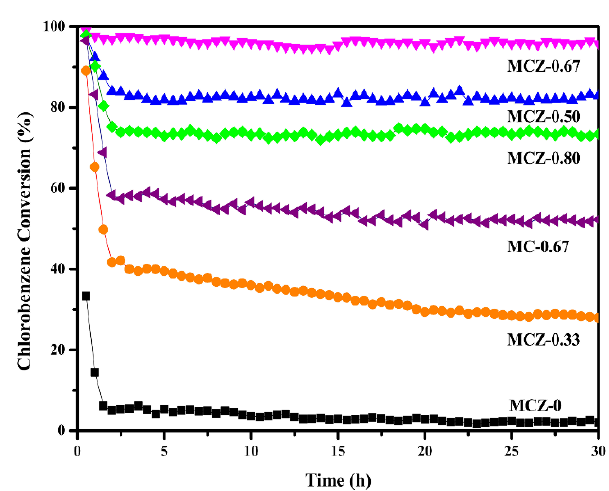
Figure 8. Stability tests of MCZ-x (x = 0, 0.33, 0.50, 0.67, 0.80) and MC-0.67 catalysts for CB elimination during 30 h of continuous reaction at 300 °C , gas composition: 1000 ppm CB, 21% O 2 ; GHSV = 20,000 h − 1 .